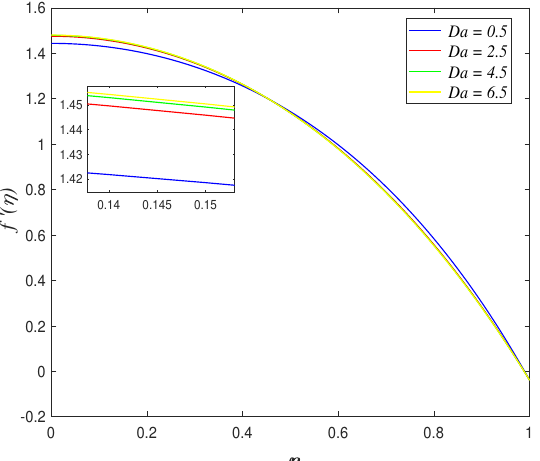
Figure 14. Impact of Da on axial velocity.